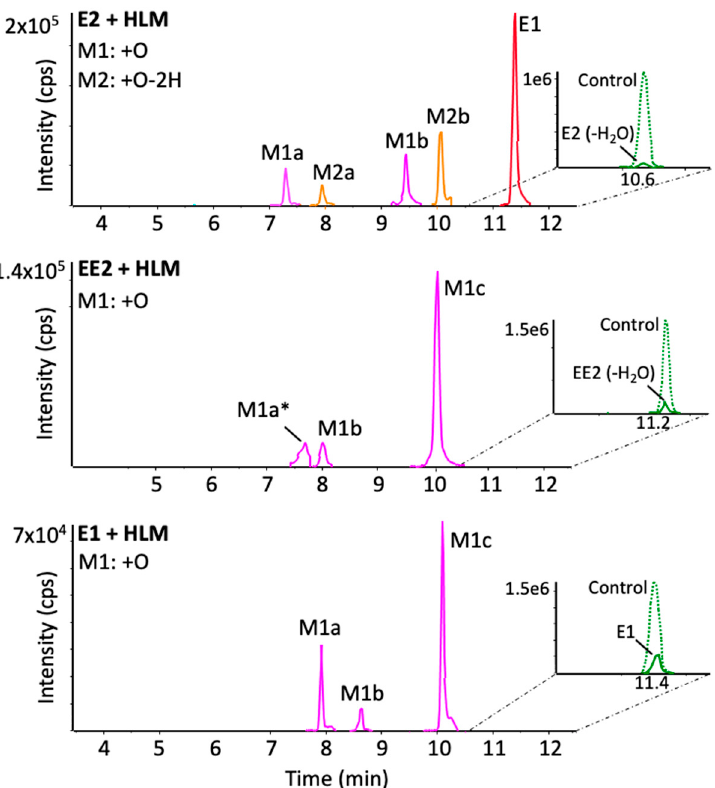
Figure 4. High-resolution extraction ion chromatograms of oxidative metabolites formed from E2, EE2 and E1 in human liver microsomal incubations. Some peaks (*) were increased 5 × for clarity. Details of measured m / z and molecular formulae can be found in Table 1.